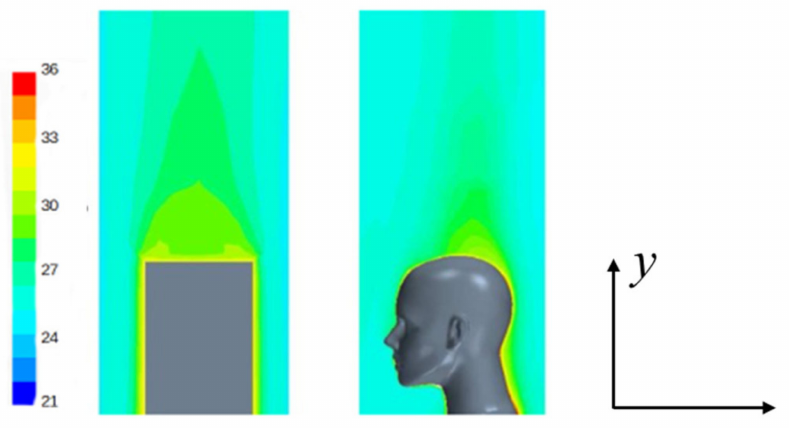
Figure 4. Temperature contours around (head of) cubic and a real manikin